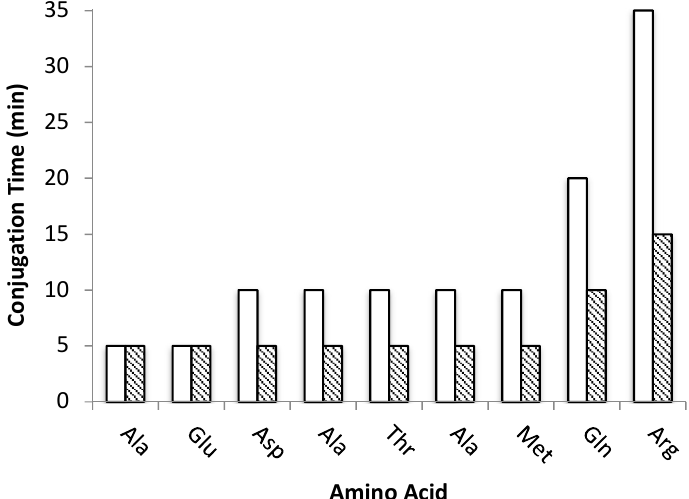
Figure 3. Conjugation times (min) for each amino acid of peptide Pep2 prepared by “classical” SPPS (white, 115 min total) and US-SPPS (dashed, 65 min total).